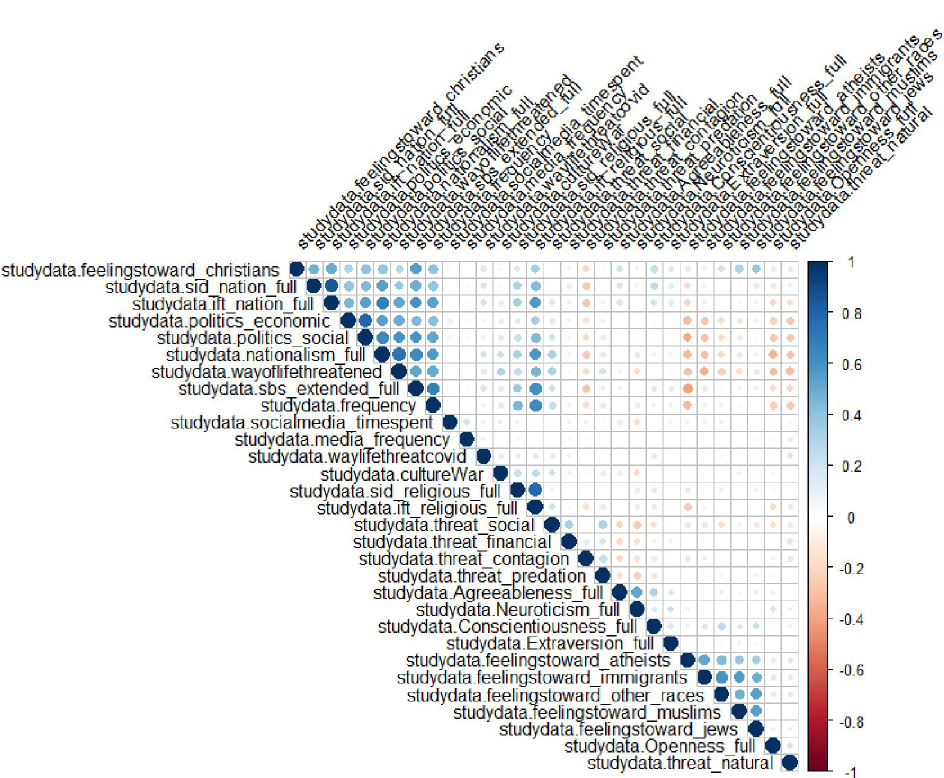
Fig 12. Correlation heatmap of variables in the study used to create our structural equation